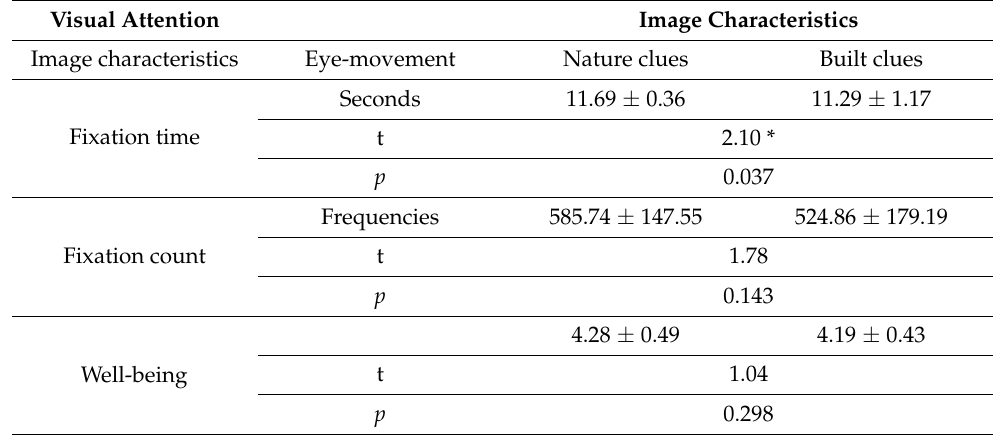
Table 1. Effects of image characteristics on older consumers’ visual attention.